Question: According to this chart, does the measure grow or shrink?
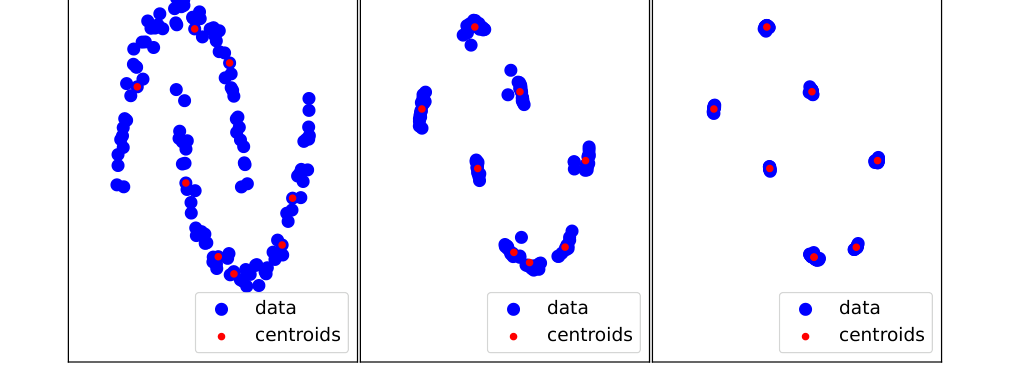
Answer: decreasing